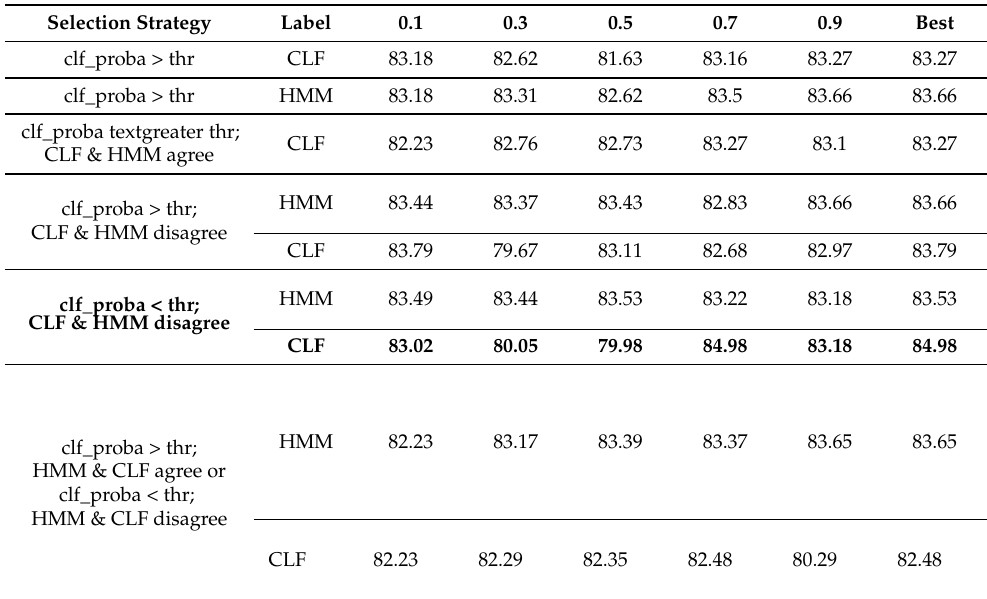
Table 10. The F1 scores produced by different semi-supervised learning selection strategies when working on the data from the 2019 SHL Challenge.